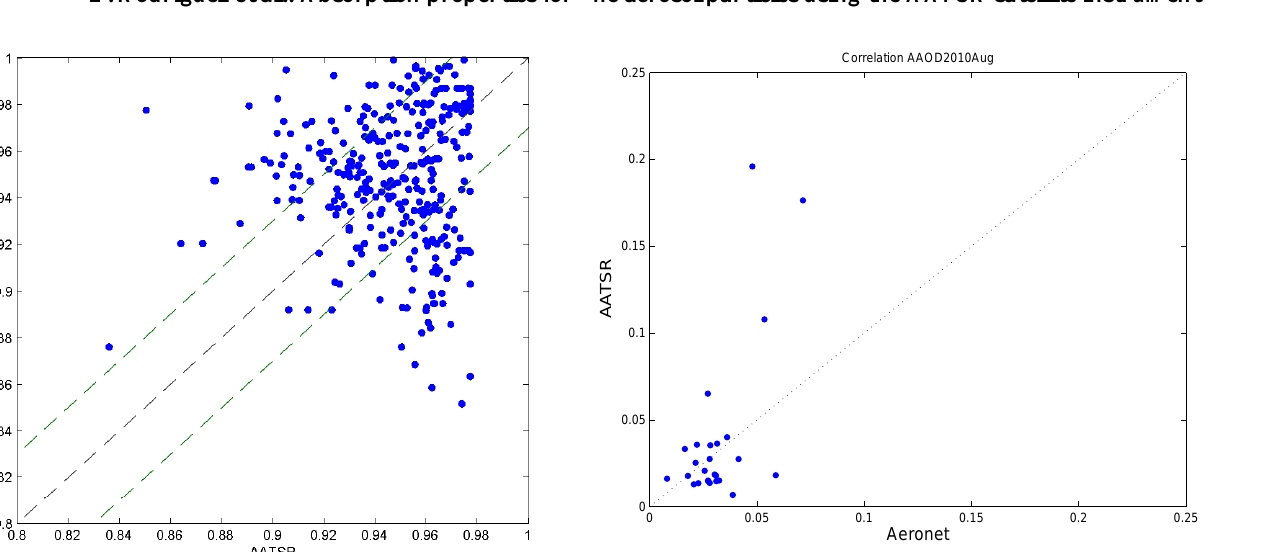
Figure 7. Comparison of AATSR and OMI SSA products on Au- gust 2010. See text for discussion.